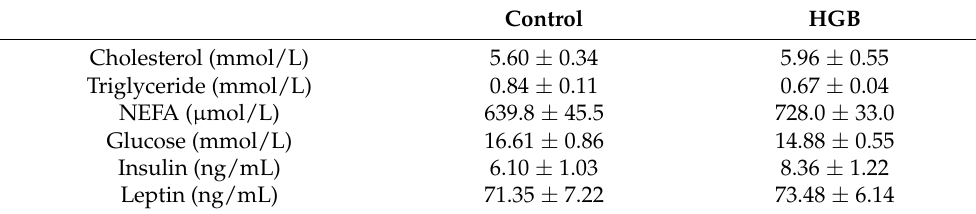
Table 5. Serum biochemical